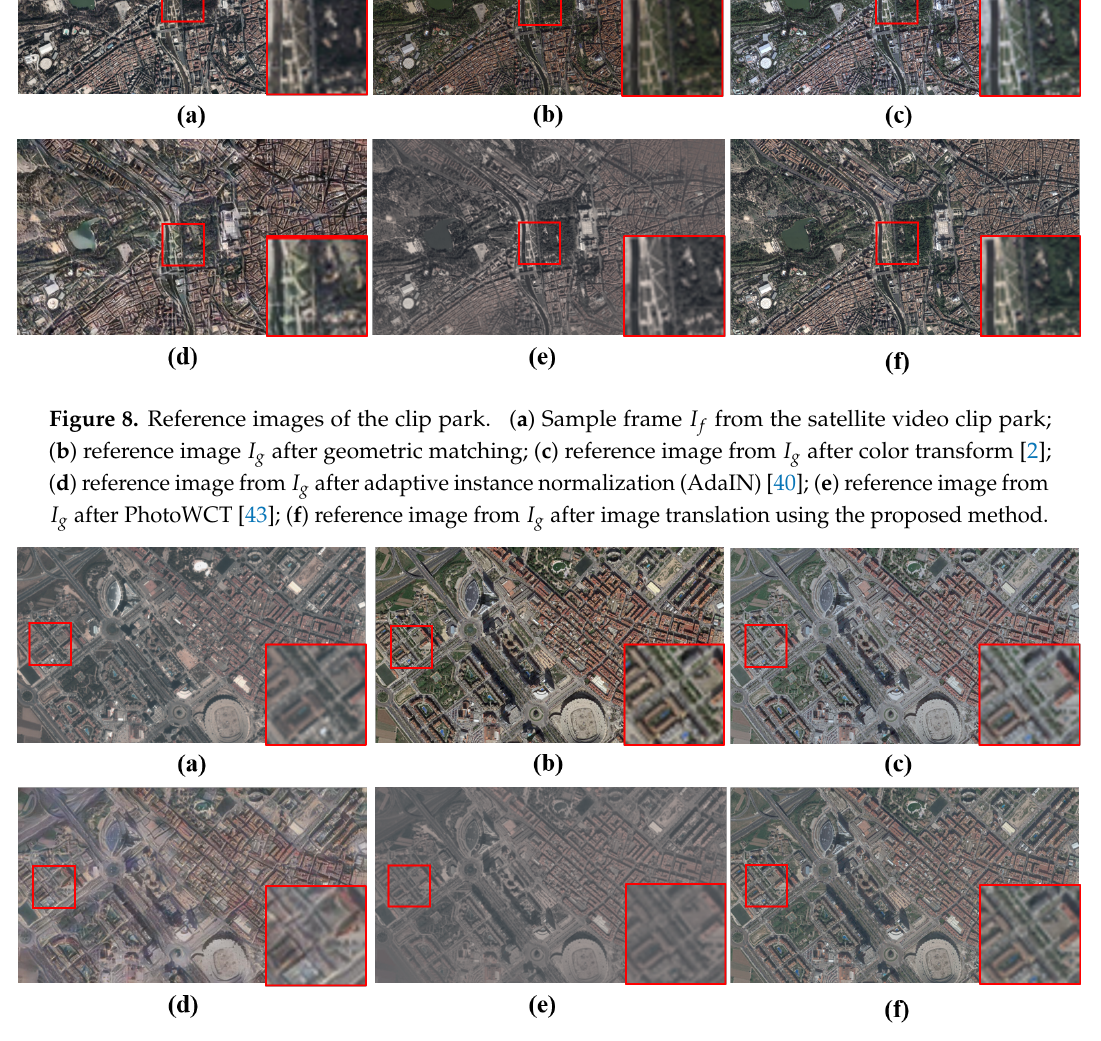
Figure 9. Reference images of the clip urban center. ( a ) Sample frame I f from satellite video clip urban center; ( b ) reference image I g after geometric matching; ( c ) reference image from I g after color transform [2]; ( d ) reference image from I g after AdaIN [40]; ( e ) reference image from I g after PhotoWCT [43]; ( f ) reference image from I g after image translation using the proposed